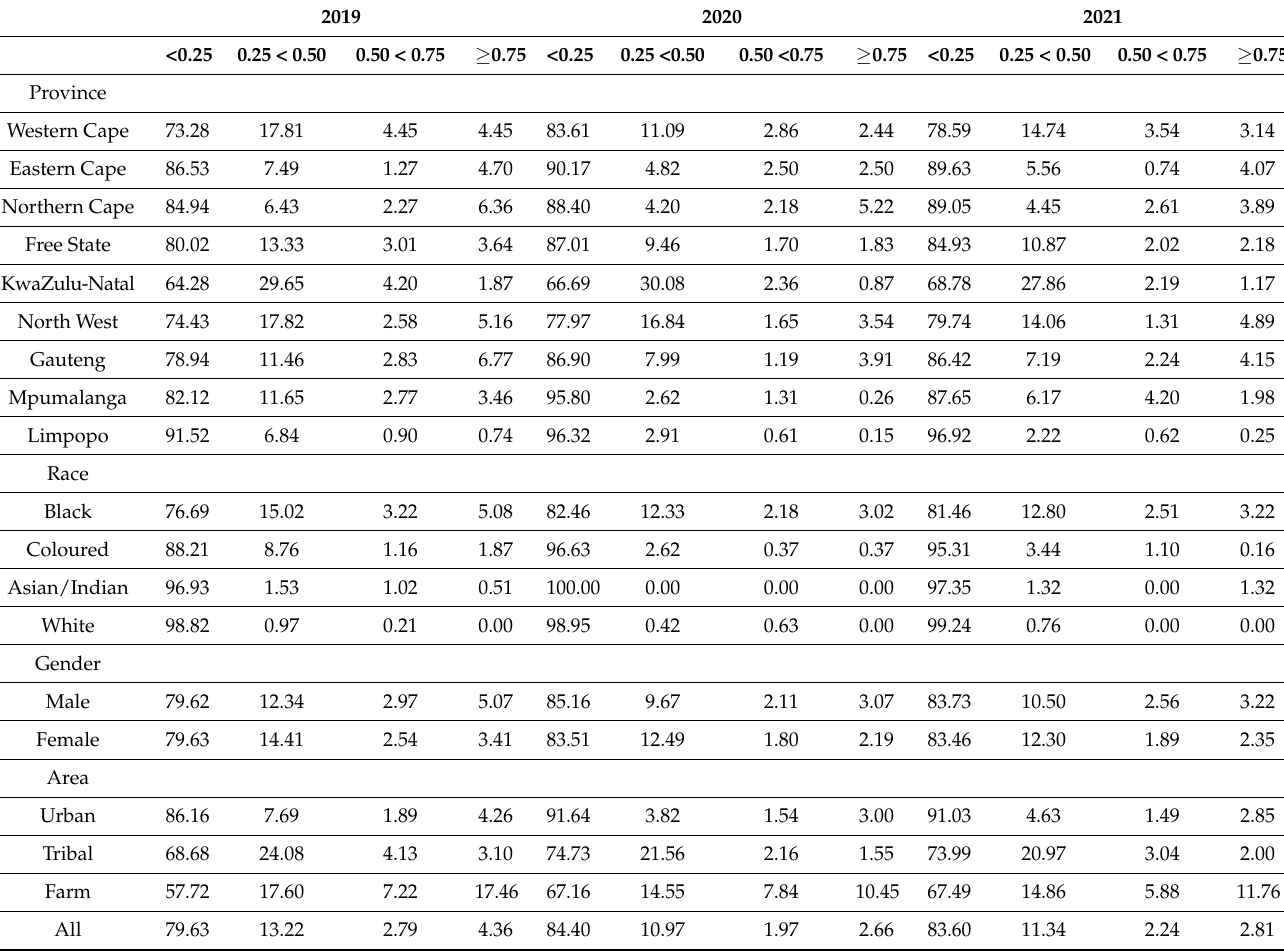
Table 2. Distribution of MEPI across the selected demographic variables in 2019–2021.